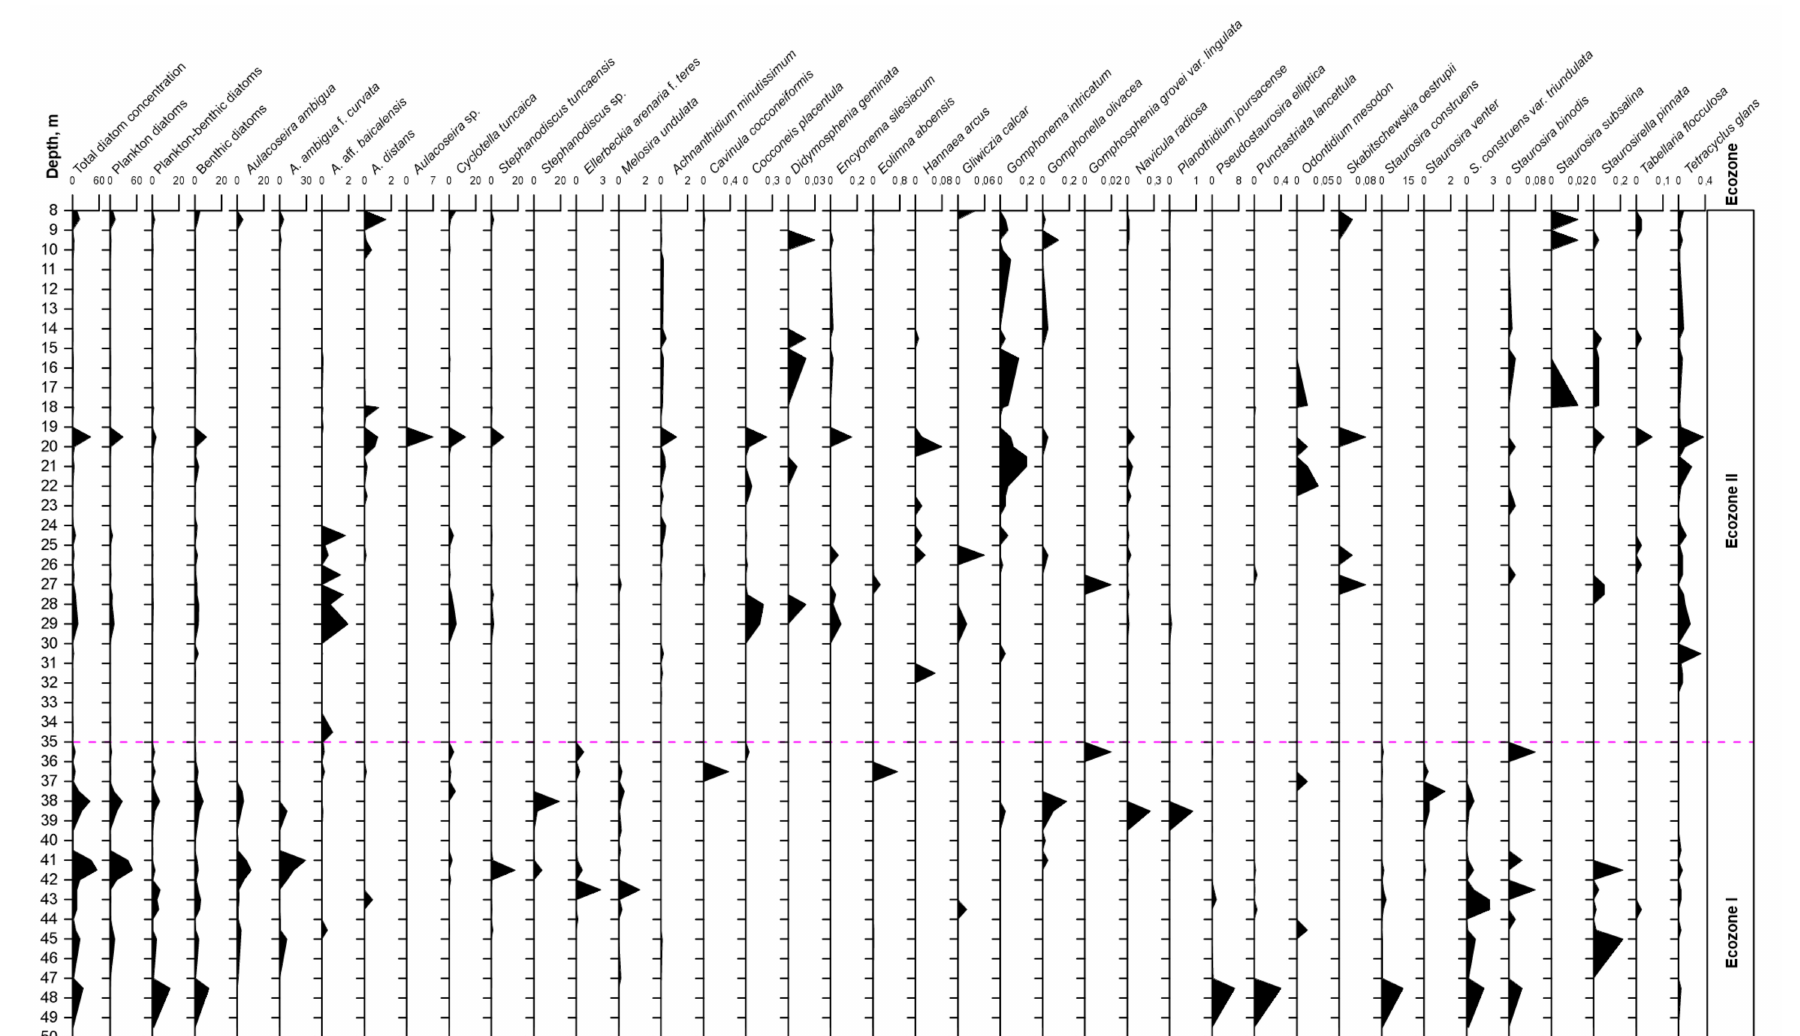
Figure 4. Diatom diagram from core Tunka-13, showing the succession of the most common taxa (valves, mln/g air-dried